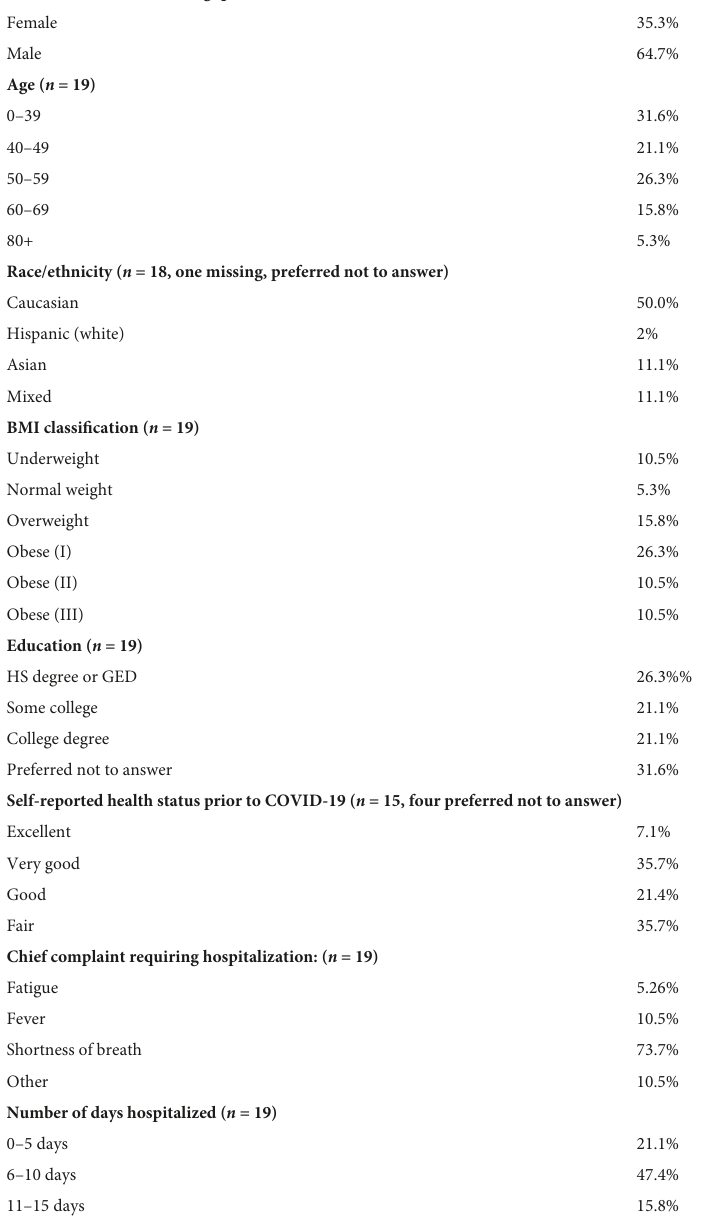
Gender ( n = 17, two missing–preferred not to